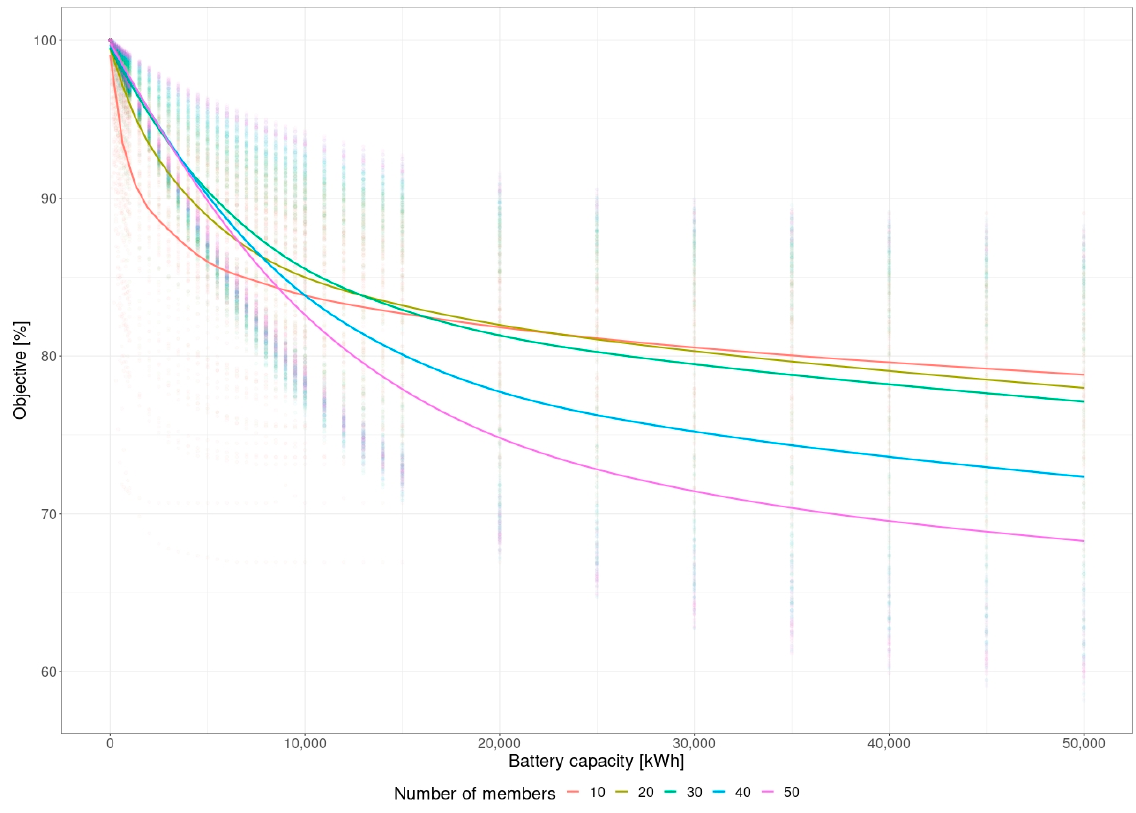
Figure 2. Simulation results of a battery addition effect depending on the battery capacity for reference energy cooperatives. Also seen are measurement points and an average value for cooperatives with a specified number of members.